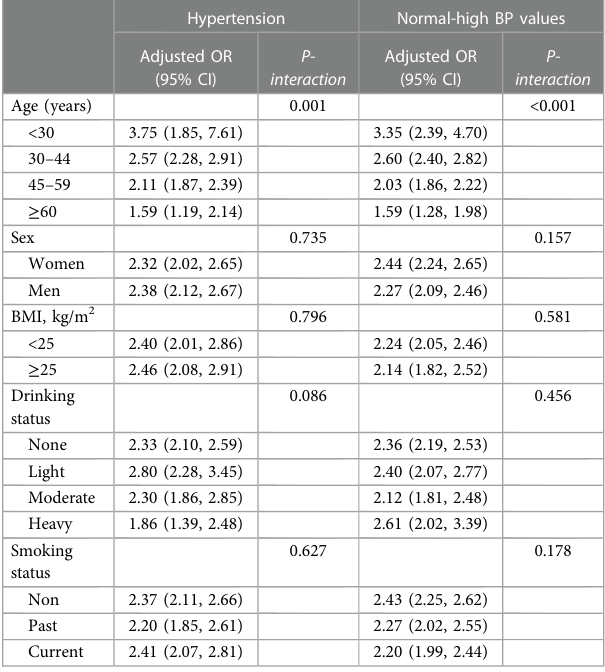
TABLE 4 Strati fi ed association between TyG-BMI and HTN/normal-high BP values by age, sex, BMI, smoking status, and drinking status.